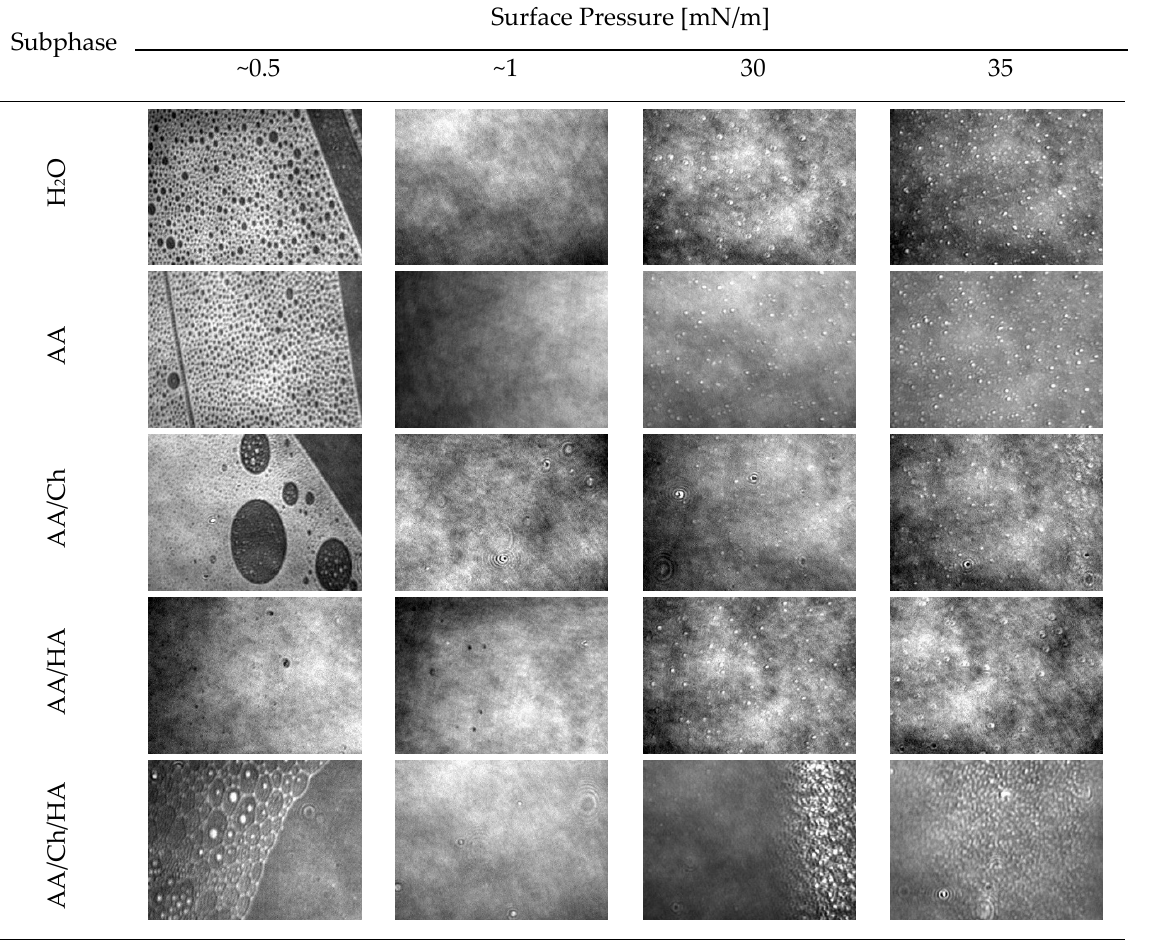
Figure 9. Structure of the E. coli lipid monolayer during their compression (at surface pressures of 0.5, 1, 30 and 35 mN/m) on the different subphases (AA–acetic acid, AA/Ch–chitosan on acetic acid, AA/HA–hyaluronic acid in acetic acid, AA/Ch/HA–chitosan in acetic acid with the addition of hyaluronic acid). Table 4. Thickness of the E. coli lipid monolayers during compression.